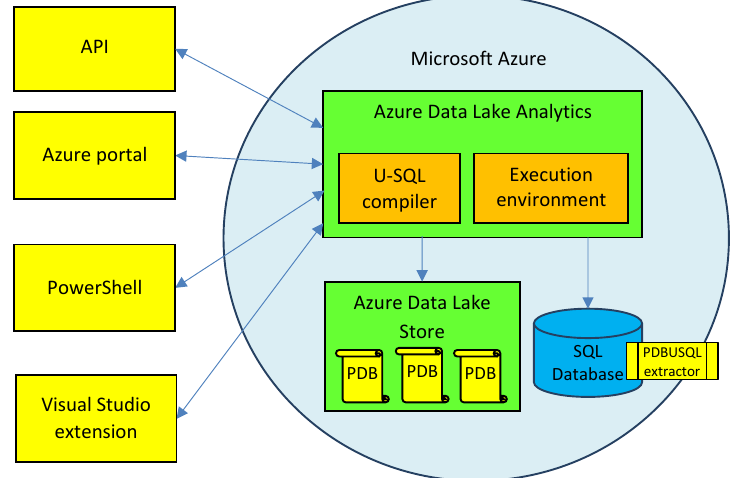
Figure 1. Architecture of our solution for extracting and processing Big macromolecular Data in the Azure Data Lake environment with the PDBUSQLExtractor . PDB files describing macromolecular data of proteins and nucleic acids are stored in the Data Lake Store. Efficient processing occurs in the Data Lake Analytics equipped with PDBUSQLExtractor